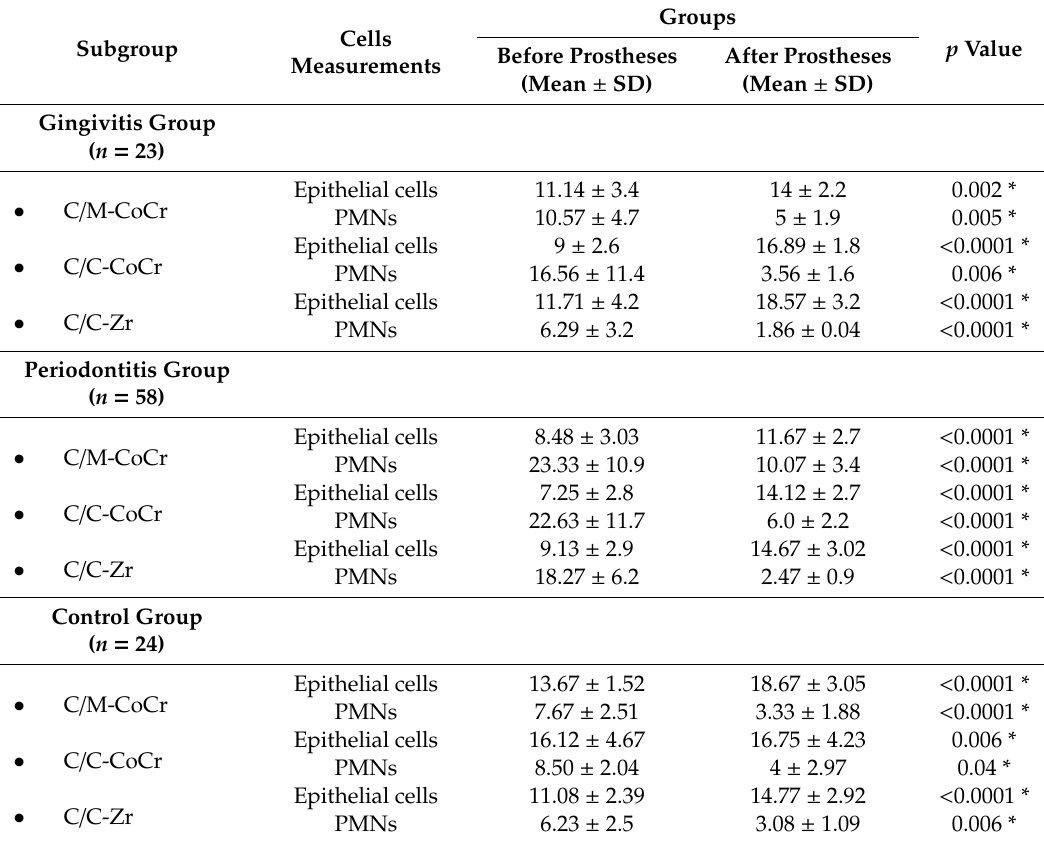
Table 1. Comparison of the dynamics of cytomorphometric indicators among patients with gingivitis, periodontitis, and healthy subjects with di ff erent fixed